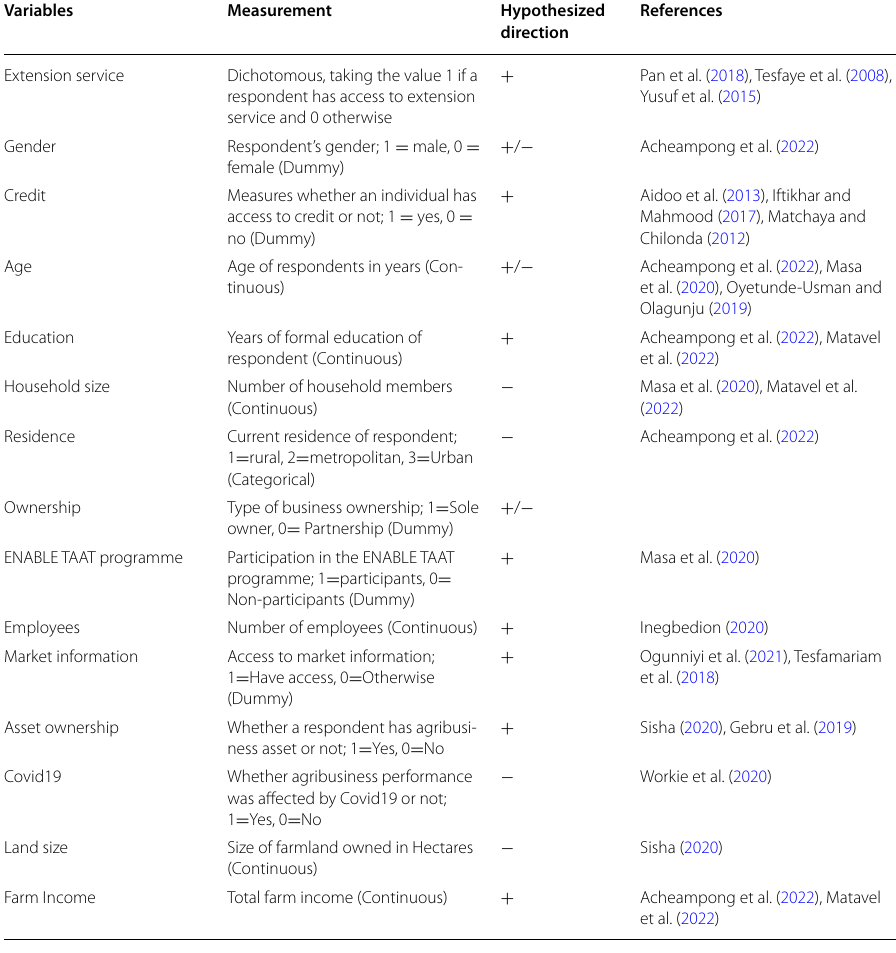
Table 5 Definition of variables included in the logit model. Source Authors